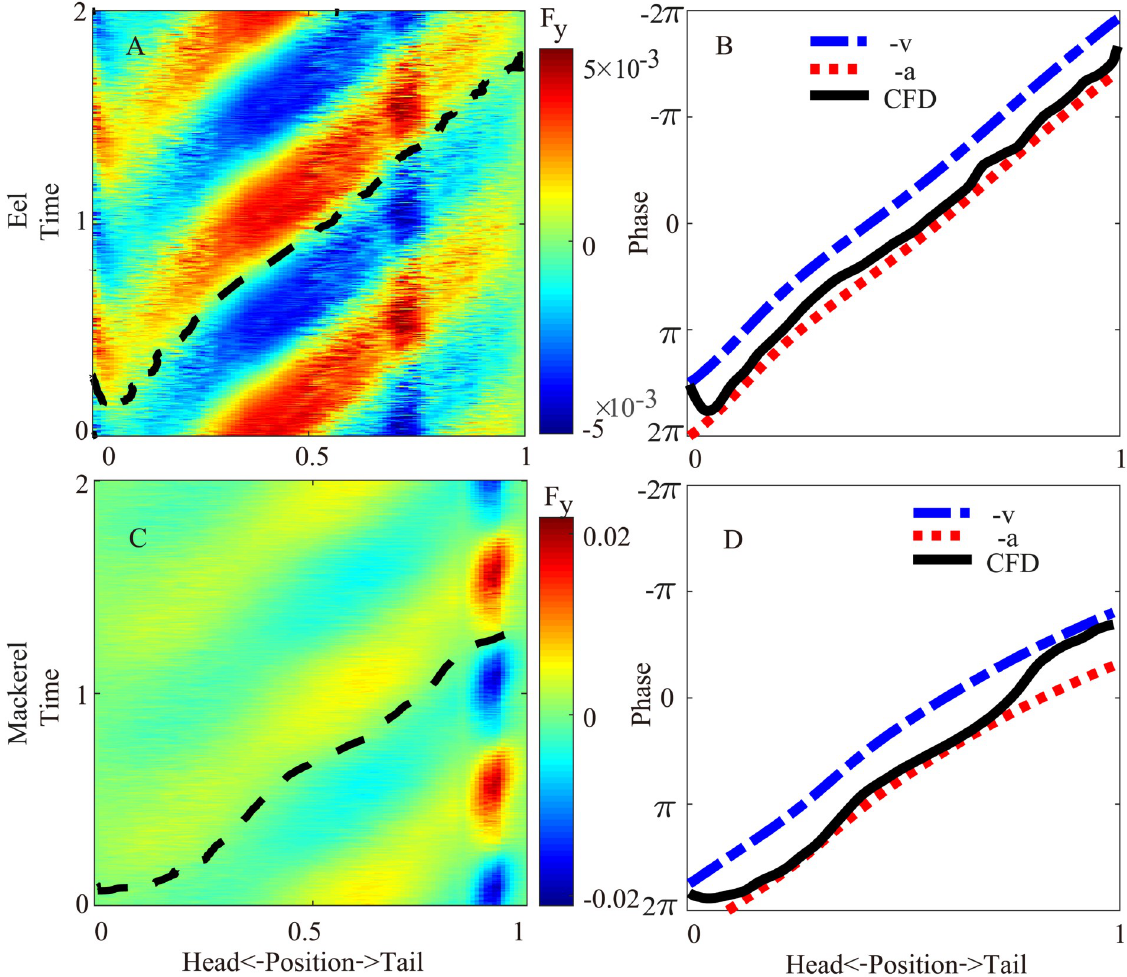
Fig 3. Lateral force ( F y ). (A & C,) Spatiotemporal distribution of the lateral force on the body for two periods from the simulation. The dashed black line indicates a zero-crossing (phase) of the force. (B & D) Comparison of the phase of the lateral force along the body from CFD (solid black line, the same as the dashed lines in A and C) with the phase of the negation of the velocity and the phase of the negation of the acceleration. A 2 π term is added or subtracted to ensure continuity.